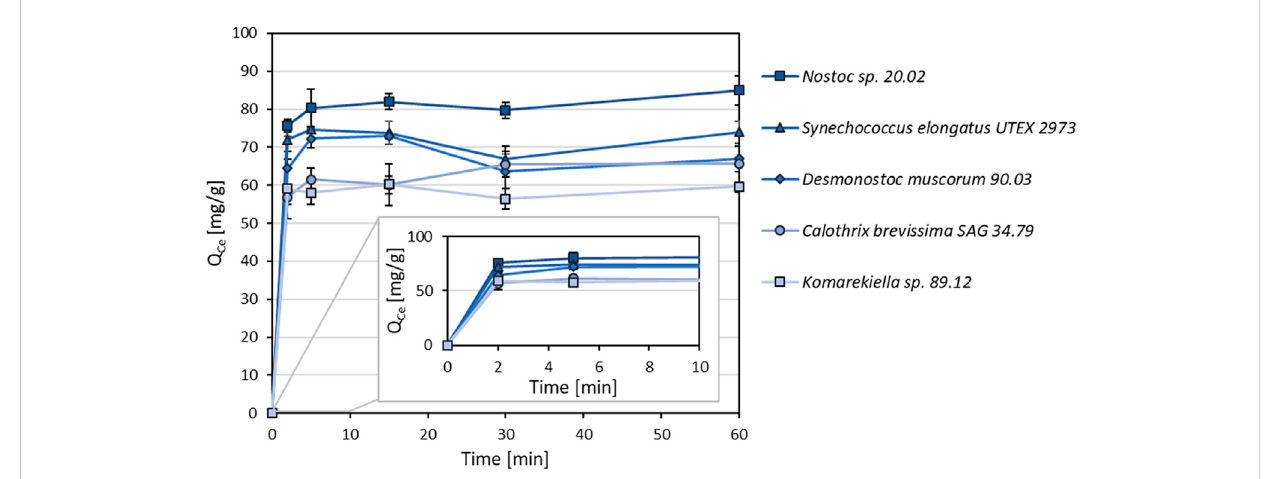
FIGURE 4 Adsorption kinetics of different cyanobacterial biomasses for Ce 3+ (Q ce , mg Ce 3+ g -1 dry mass) with incubations times between 2 – 60 min (n = 3).